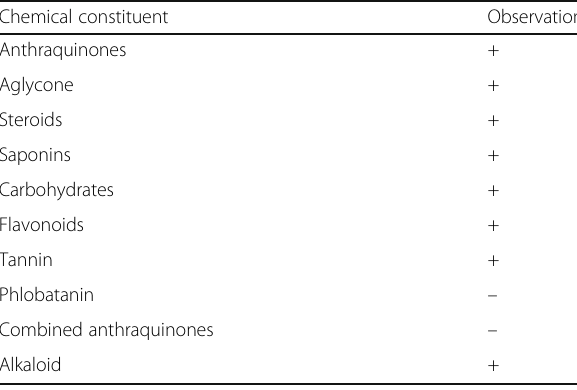
Table 1 Preliminary phytochemical screening of ethanol